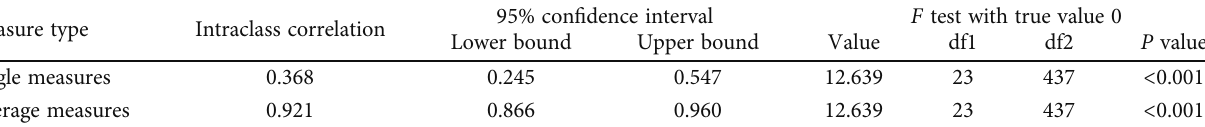
Table 5: Intraexaminer reliability by calculating the intraclass correlation coe ffi cient for single measures and average measures. Measure